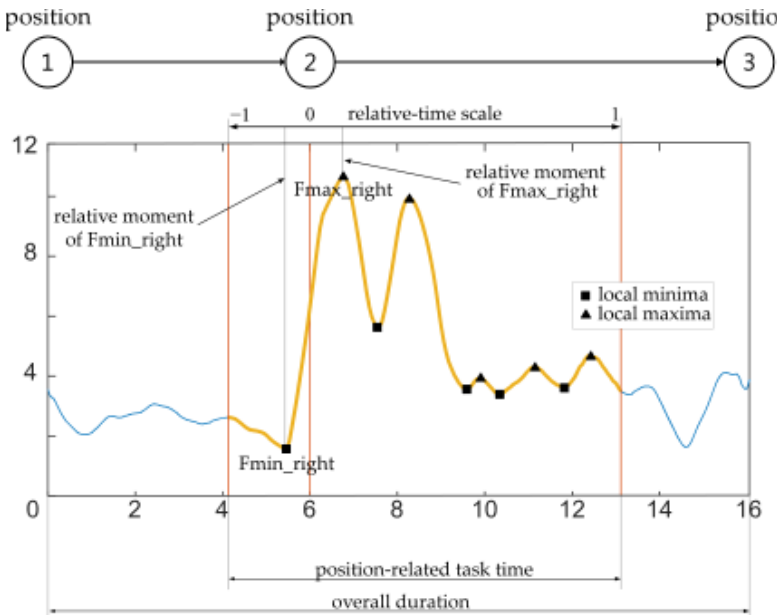
Figure 5. Parameters extracted from the acquired force signal.